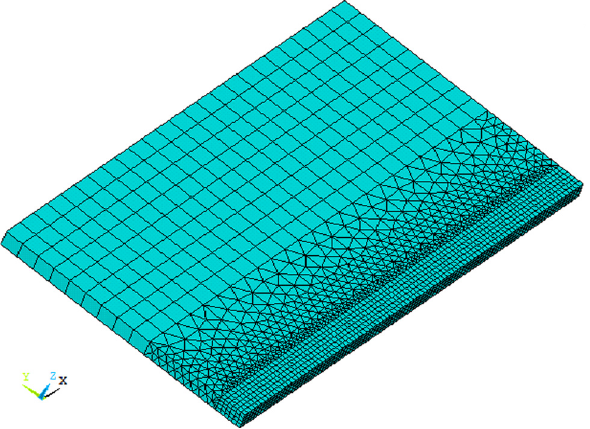
Figure 1: Finite element mesh. Figure 2: Double ellipsoidal heat source model.